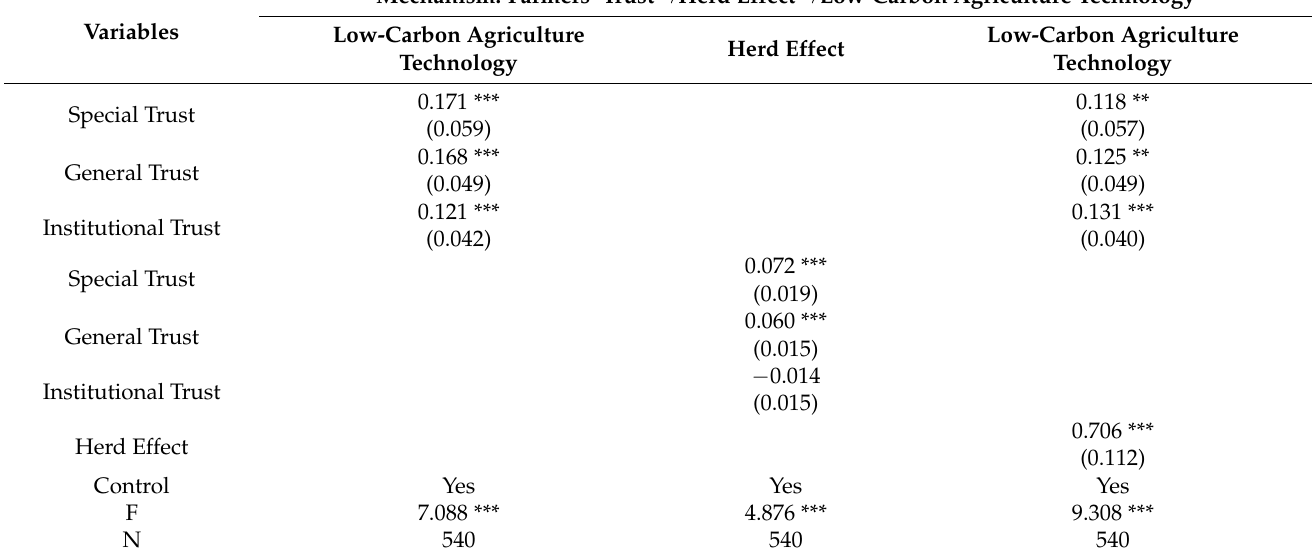
Table 4. Mediating effect analysis of herding effect.